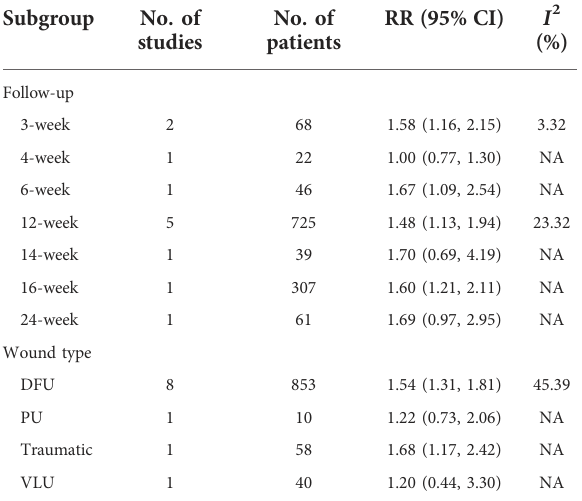
TABLE 3 Subgroup analysis for wound healing rate.